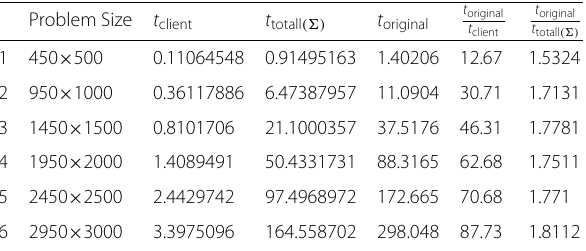
Table 8 Ax ≡ b mod 12289 with parameters f ( m ) = 2 m − 3, g ( n ) = 2 n − 3 (Continue with Table 7, unit:s) Problem Size t